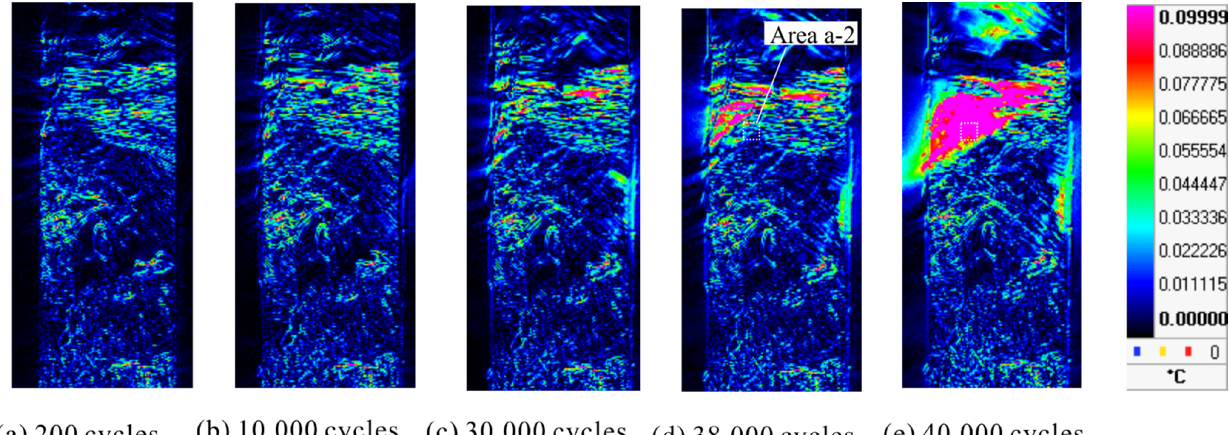
Figure 5. Change in the second harmonic temperature components.